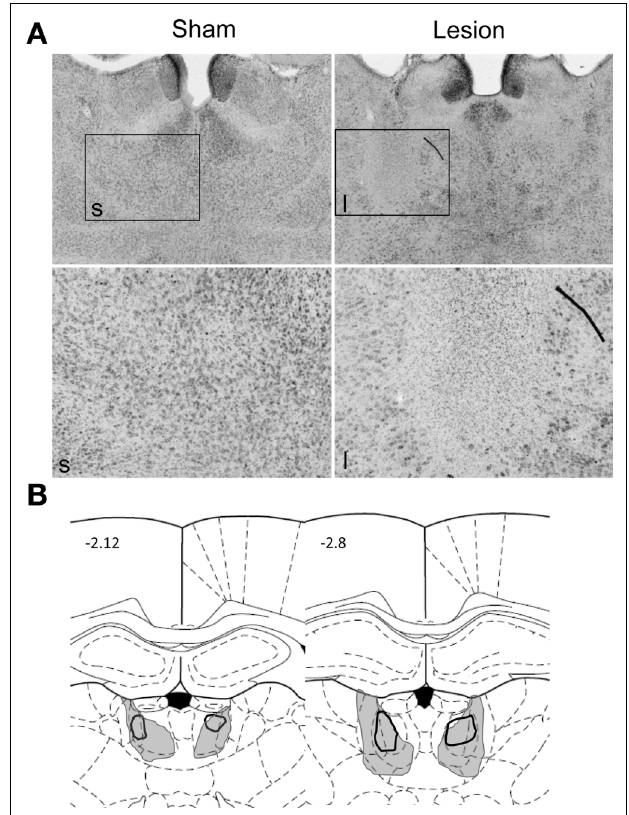
FIGURE 1 | Histological analysis of MD lesions. (A) Photomicrographs of representative sham (left) and MD lesions (right) at low (4 × , above) and high (10 × , below) magnifi cation. (B) Illustration of the largest (gray shading) and smallest (black outline) extent of lesions. The diagrams are based on a rat brain atlas (Paxinos and Watson, 1998). The numbers indicate distance in mm from